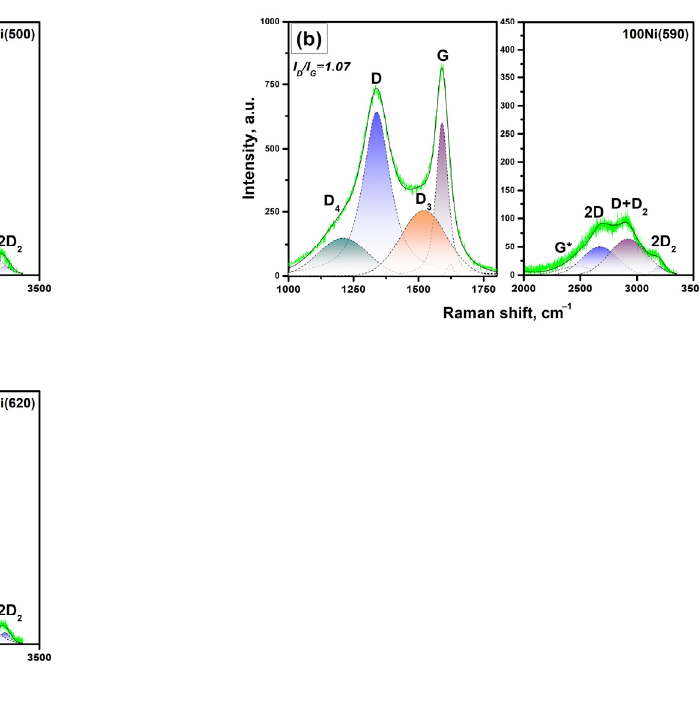
Figure 11. Raman spectra of the carbon product formed over the 100Ni samples for a region of the bands of first and second orders: ( a ) 100Ni(500); ( b ) 100Ni(590); ( c ) 100Ni(620).